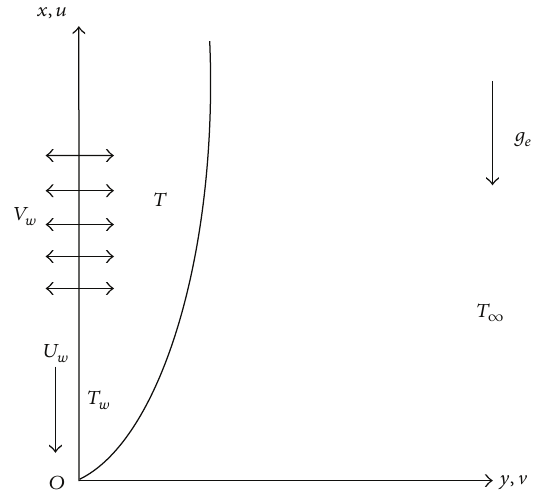
Figure 1: Physical model and coordinate system.